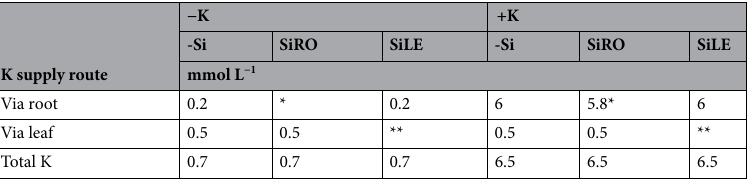
Table 1. Amount of K provided and adjustment between control (–Si), Si via roots (SiRO) and Si via leaf spraying (SiLE) treatments in the second experiment. *Received 0.2 mmol K via SiNaK; ** received 0.5 mmol via